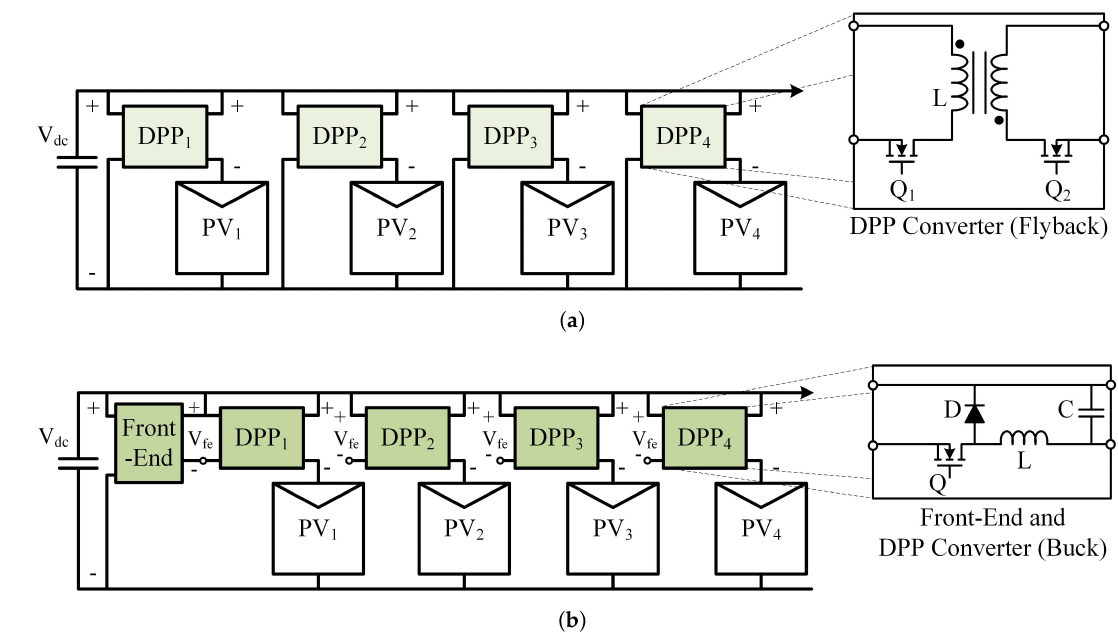
Figure 3. System diagram of parallel DPP converters ( a ) without and ( b ) with a front-end converter, where V fe is the front-end converter output voltage, L is inductance, Q indicates a switch, D indicates a diode, and C is